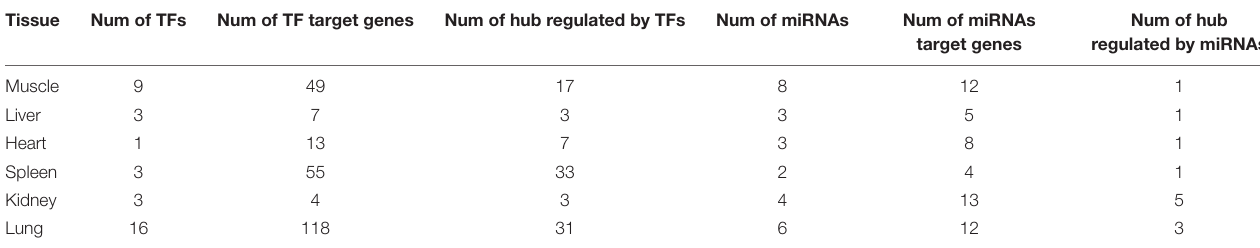
TABLE 4 | Detailed information of gene regulatory networks in six tissues of Tibetan pigs. Tissue Num of TFs Num of TF target